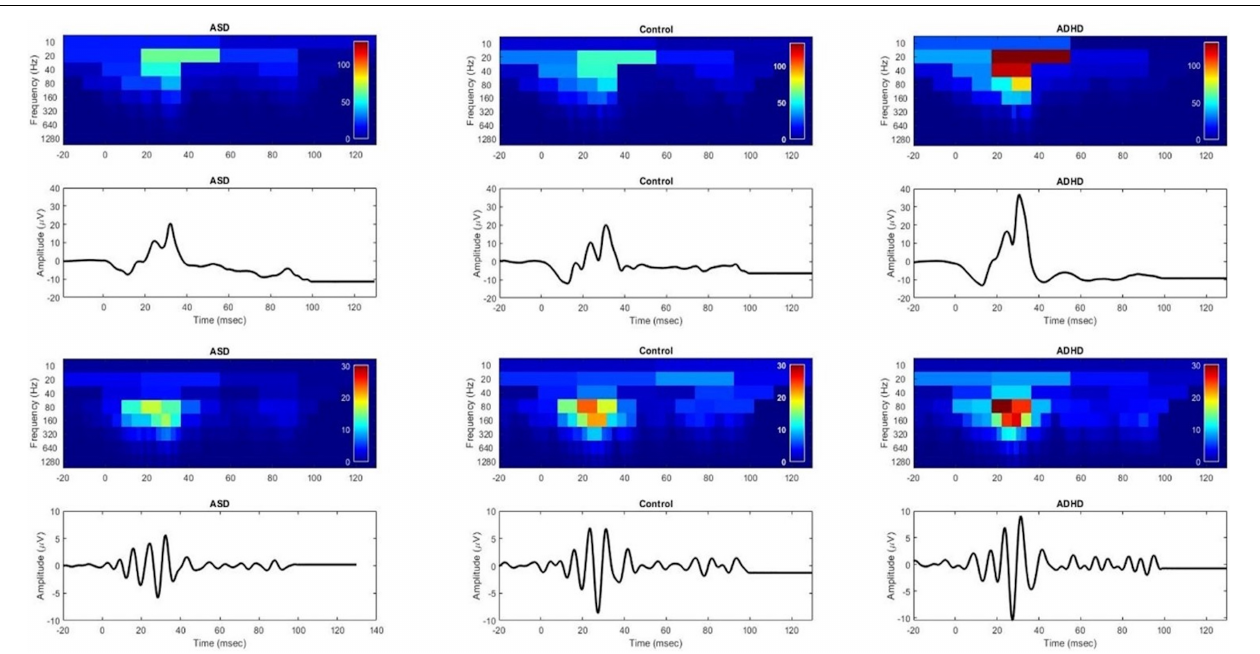
FIGURE 1 | DWT scalograms of the ERG and OPs waveforms for ASD, control and ADHD normalized to the color scale of the ADHD participant using a Flash Strength of log 1.204 photopic cd.s.m − 2 . Red indicates greater energy levels and blue low energy levels. Upper panel shows the ERG waveforms and lower panels show the corresponding OP waveforms. In the upper panel the b20 and b40 bands of the ASD scalogram are not significantly different from that of the control. In contrast the ADHD participant’s recording shows increased energy within all frequency bands of the scalogram compared to the ASD and control. The lower panels, show a reduced op80 and op160 energy in the ASD participant compared to the